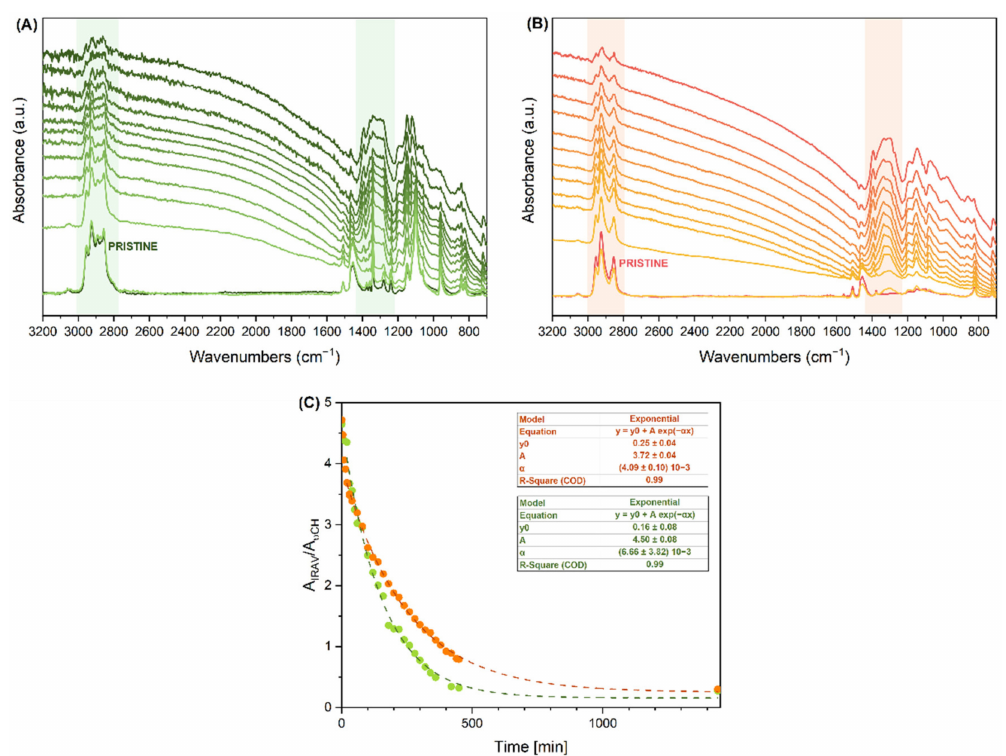
Figure 8. Evolution over time of the infrared spectrum of P3HT:PEO (green lines, panel ( A )) and P3HT (orange lines, panel ( B )) nanofibres doped with iodine vapours. A colour scale—from darker to lighter—has been adopted for plotting the spectra from the highly doped sample to those showing negligible IRAV intensities. Panel ( C ) shows the trend, over time, of the ratio among the area of the bands highlighted, namely A IRAV /A CH : the green dots refer to P3HT:PEO spectra—the contribution of CH stretching transition ascribed to PEO has been removed (see text); orange dots refer to P3HT